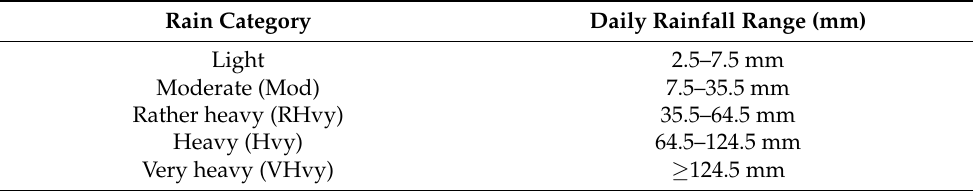
Table 4. Five rainfall categories based on daily rainfall amounts have been used in this study. The daily rainfall ranges for these five rain categories are adopted from the IMD. Daily rainfall less than 2.5 mm is not considered, and two rain categories—very heavy and extremely heavy—are grouped into very heavy rain category in this